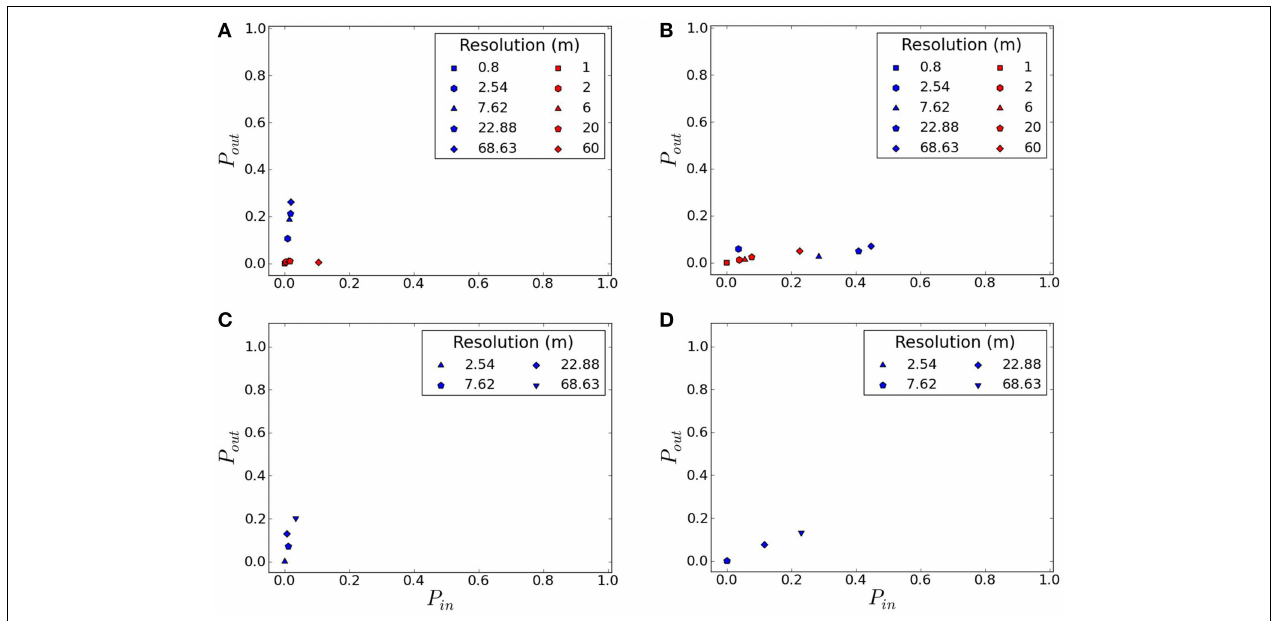
with the highest mesh resolution where convergence errors are assumed to be most reduced. ANUGA results are in blue, TsunAWI results are in red.